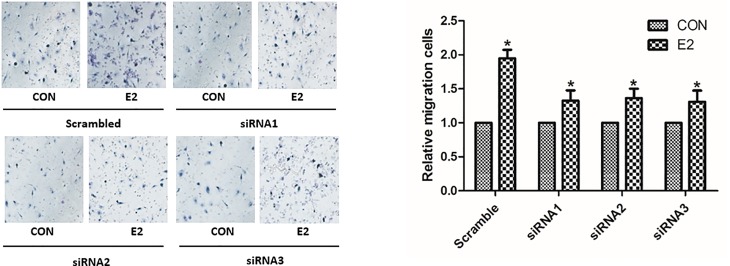
Transwell assay showed E2 promotes HUVEC migration via striatin.After transfected with striatin siRNA1, 2, 3 or scrambled siRNA for 24h, transwell experiments were performed. Representative images of transwell experiments are shown. The number of the invaded cell in the lower surface of the membrane in CON group was normalized to 1, *p<0.01 versus CON. Bars represent SD, n = 6.